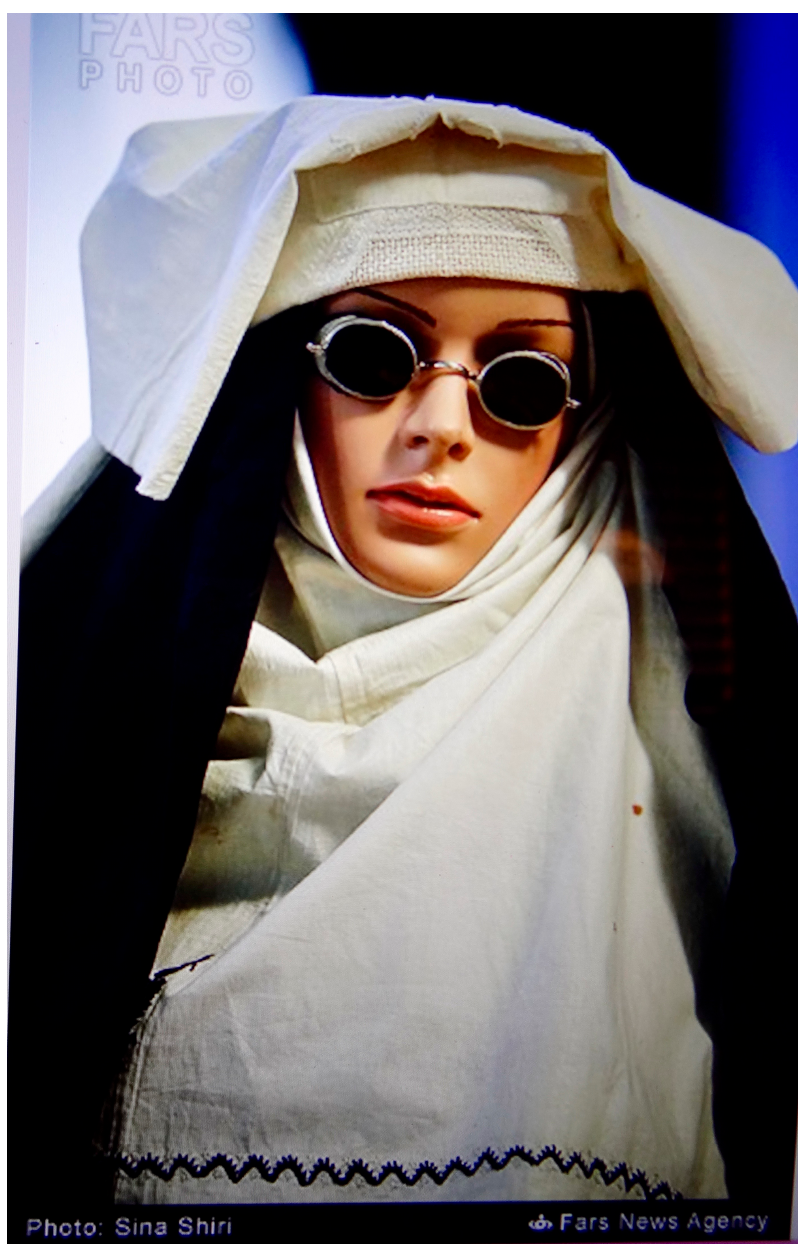
Figure 10. Fashion show organized by the Iranian government. This example is a reminiscent style of Qajar woman’s hijab ( chador va chaghchor see figure# 1 for comparison) that was abolished by kashf e hejab or forced unveiling edict in 1936. Photo Credit: Sina Shiri, FARS News Agency, Iran. 2013.